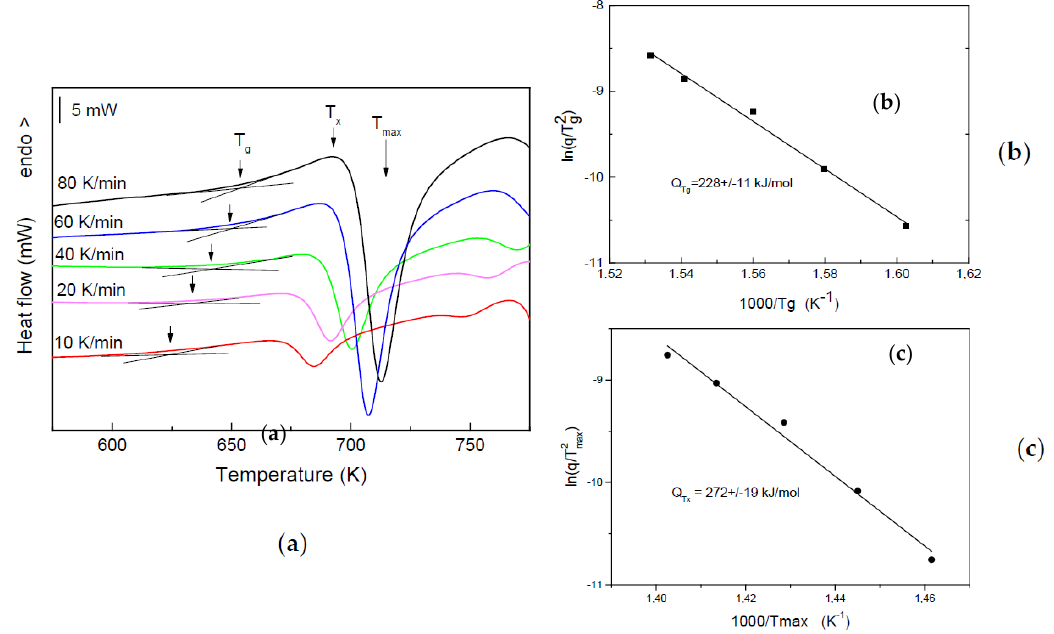
Figure 4. DSC scans of the as-cast Pd 40 Ni 40 Si 20 ribbon, measured with heating rates in the range 10–80 K / min ( a ); Kissinger plot of glass transition temperature T g ( b ) and Kissinger plot of the temperature of crystallization T max (temperature of the maximum of the first crystallization peak) ( c ).